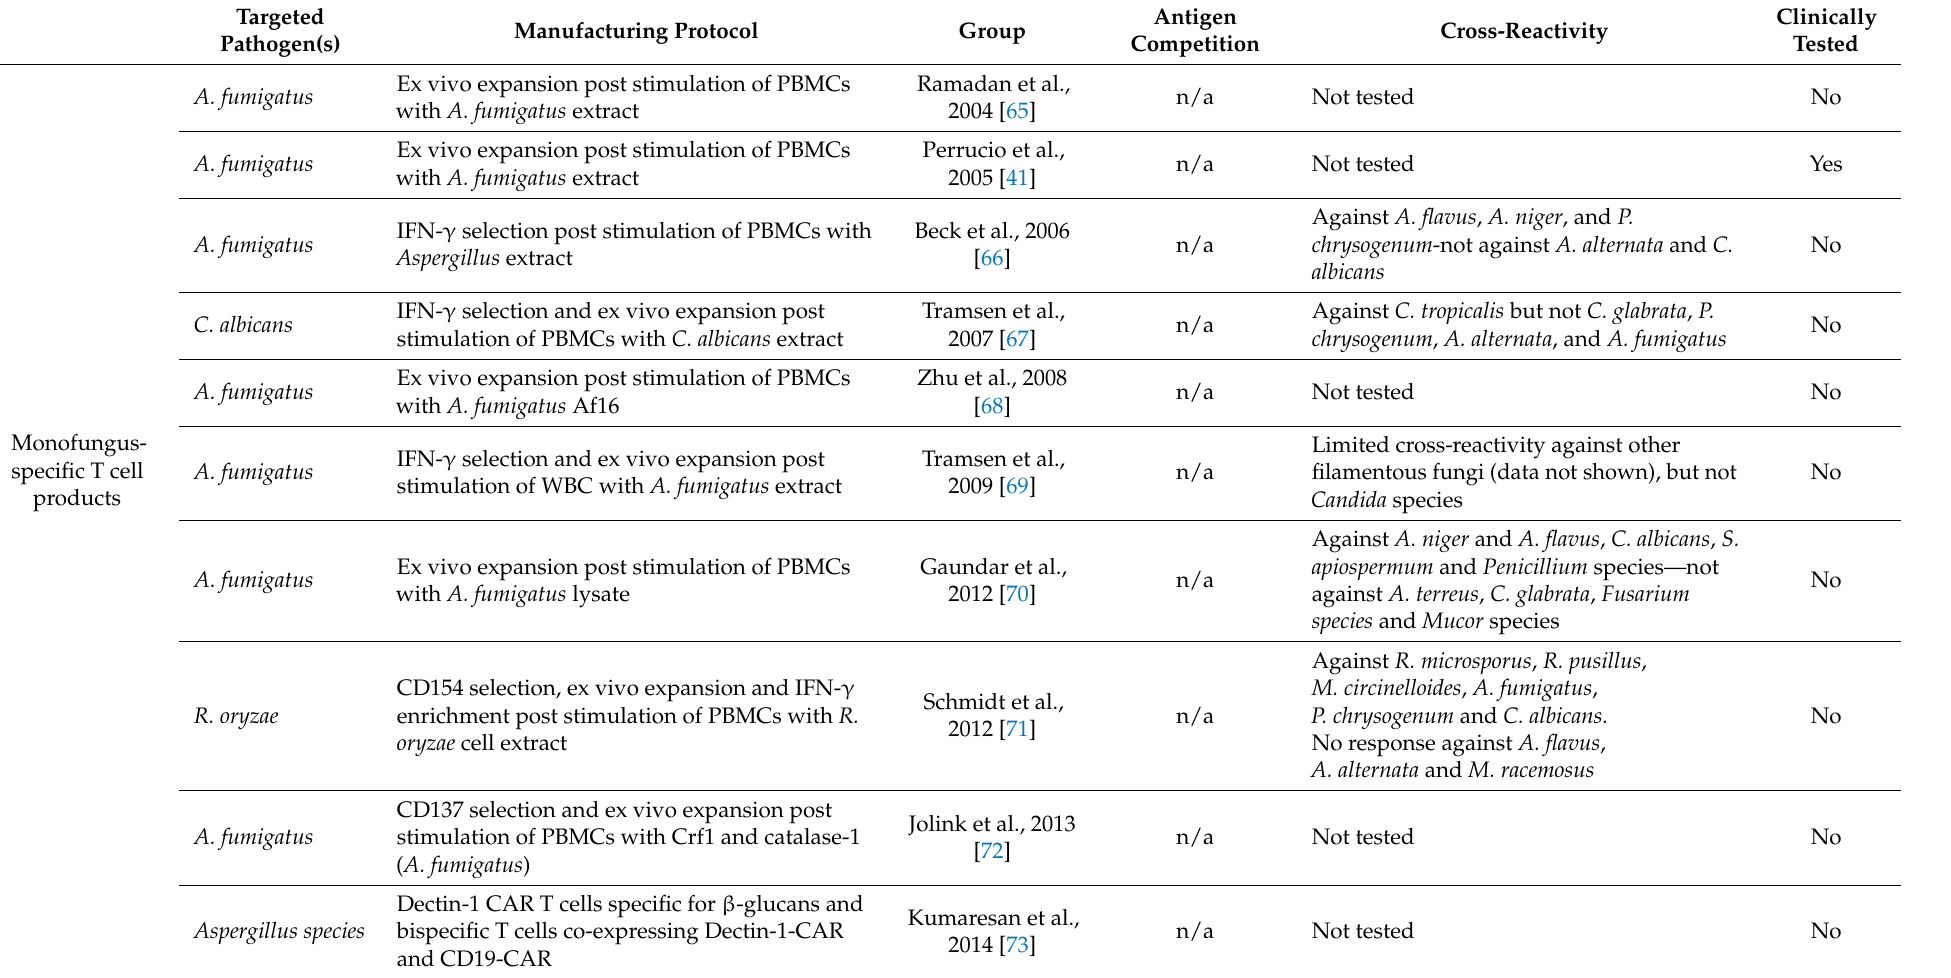
Table 1. Preclinical and clinical studies of the generation of fungus-specific T